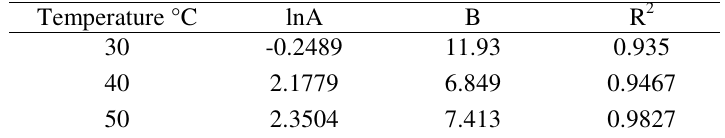
Table 3. Parameters of Temkin adsorption isotherm of methylene blue onto activated babul seed